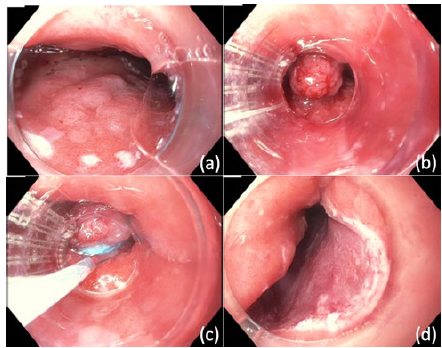
Figure 1. Ligation-assisted endoscopic mucosal resection (EMR). ( a ) Nodular mucosa representing high grade dysplasia in Barrett’s esophagus ( b ) Band deployed to create pseudopolyp ( c ) EMR performed using hot snare ( d ) Site of resection after ligation-assisted EMR.